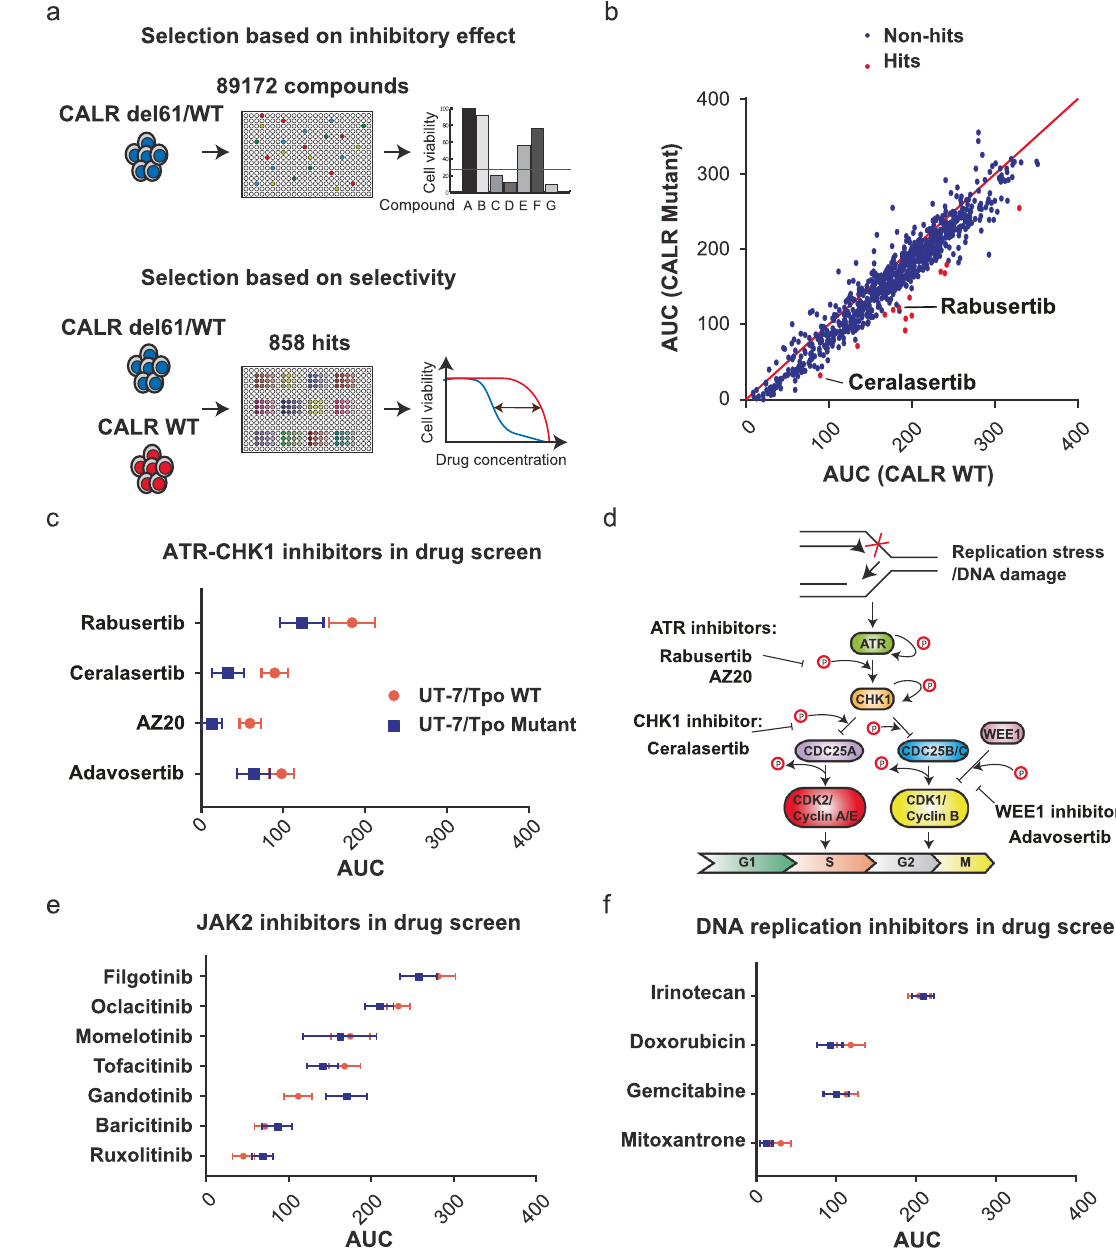
Fig. 1 High-throughput compound screen identi fi es ATR-CHK1 inhibitors as synthetic lethal with mutant CALR. a A schematic diagram of compound screen work fl ow. The UT-7/Tpo CALR del61/WT cell line was used for the initial screen. Each compound was used at 10 µM or higher, in a 3-day cell viability assay. Selected compounds were used in the validation screen with both UT-7/Tpo CALR WT and UT-7-Tpo CALR del61/WT cell lines against 4 doses of each compound. b The plot of the area under the curve (AUC) of all the compounds tested in the validation screen. After the validation screen, the AUC was calculated as the sum of all percentage of control (POC) values of each drug in a 4-dose response. Each POC value was calculated as a mean of 3 technical replicates. Each dot represents one compound tested on the screen. Red dots indicate the compounds identi fi ed as selective inhibitors of CALR mutated cells. c A comparison of AUC of CALR WTand mutated cells from the four inhibitors of the ATR-CHK1 pathway. A larger AUC value indicates a lower inhibitory effect on the cell line. d A schematic diagram of the ATR-CHK1 pathway as well as the targets of the four ATR-CHK1 inhibitors. e A comparison of the AUC of CALR WT and mutated cells to the JAK2 inhibitors tested on the screen. f A comparison of the AUC of CALR WT and mutated cells to the DNA replication inhibitors tested on the mutant cells in G2 upon treatment. Continuation of the treatment induced in the mutant cells, in the presence or absence of TPO to 72 h caused most of the mutant cells to become blocked in S- (Fig. 4a left panel). When DAPI was co-stained with γ -H2AX, nearly phase and these cells were γ -H2AX positive (Fig. 4b). Taken all the S-phase CALR mutated cells were γ -H2AX positive when together, the data support the conclusion that CALR mutated cells treated with MK8776, compared to a signi fi cantly lower percen- accumulate replication stress and S-phase arrest upon CHK1 tage (3-fold difference) of γ -H2AX positive cells in the control cell inhibition. line (Fig. 4a right panel). We also observed a lower fraction of